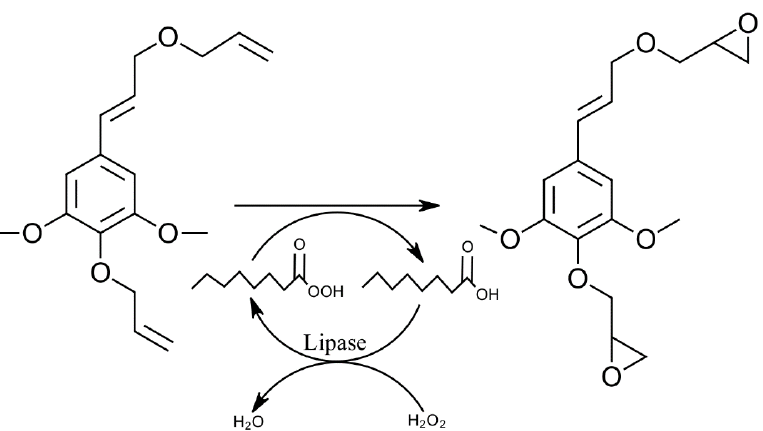
Figure 5. Epoxidation of alkylated lignin (represented as sinapyl alcohol) using a lipase, hydrogen peroxide, and caprylic acid.